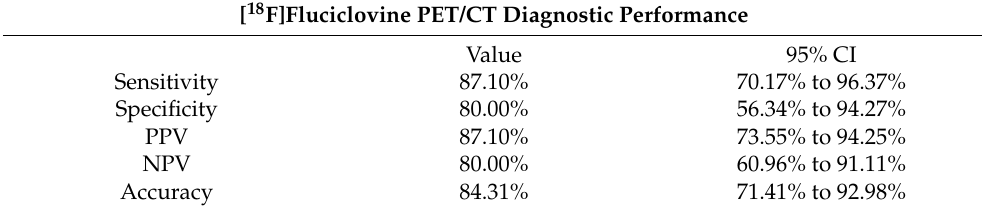
Table 2. Diagnostic performance of [ 18 F]Fluciclovine PET/CT.